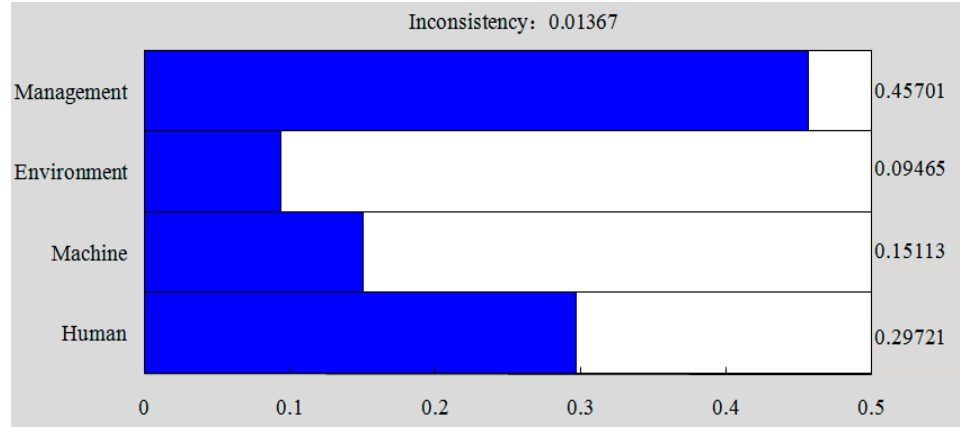
Figure 3. Consistency test results.